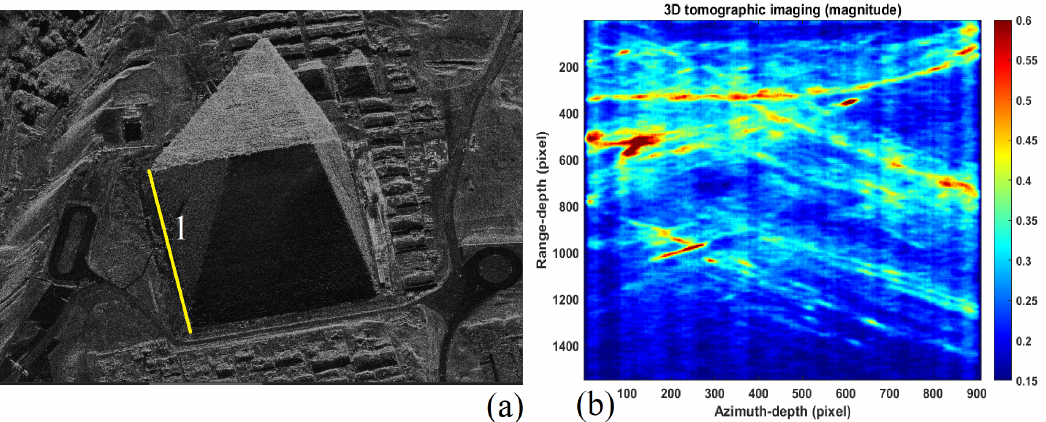
Figure 34. SAR images. ( a ): SLC SAR image (magnitude). The tomographic line 1 is oriented along the Northern-side of the pyramid. ( b ): Tomographic result